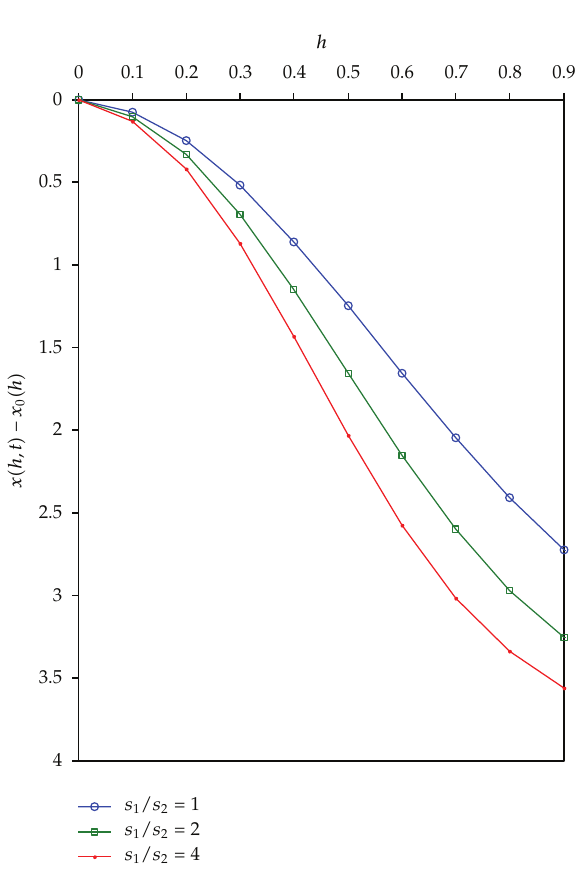
Figure 8: The e ff ect of elasticity on the drainage rate for α (cid:8) 1 and μ 1 (cid:8) 1. Figure 7. The e ff ect of the elasticity on the drainage rate is shown in Figure 8 for three liquids of which liquid 1 is the most elastic and liquid 3 is the least elastic. Liquid 1 drains more rapidly than liquid 2, which in turn drains more rapidly than liquid